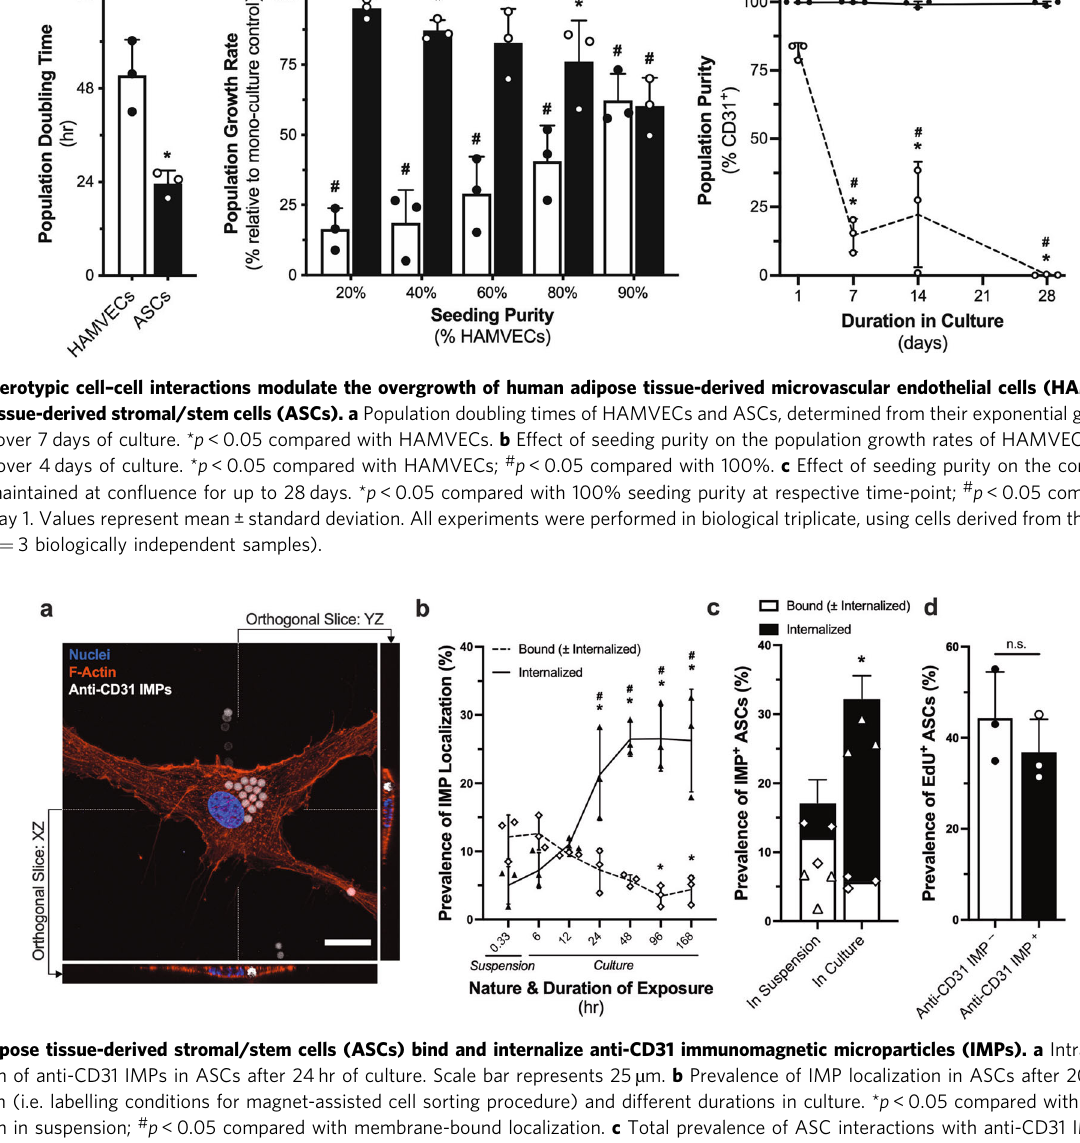
through a DNA linker, generating cleavable (c)IMPs. These anti- CD93 cIMPs were slightly but signi fi cantly larger in modal diameter than the commercial anti-CD31 IMPs (4.8 ± 0.5 µm vs.